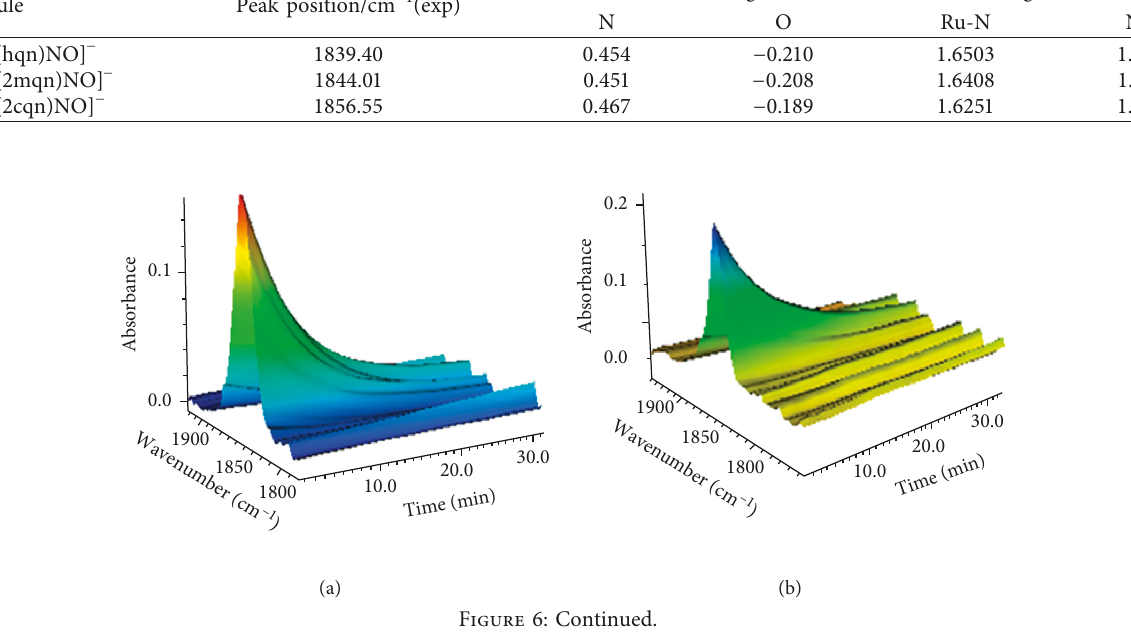
Table 4: Natural atomic charges and Wiberg bond index of NO in the three [RuCl(QN)NO]